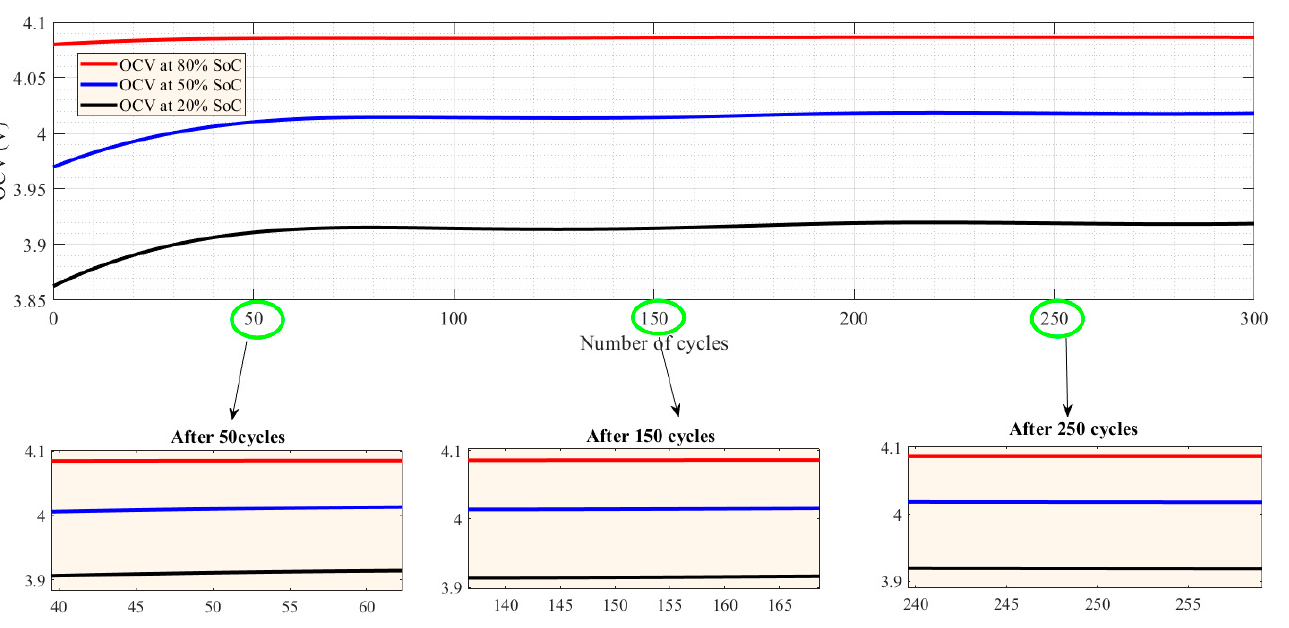
Figure 5. OCV pattern at 25 °C under charge–discharge STPs after 300 cycles during the lifetime of the 3Ah NMC Li-ion battery.